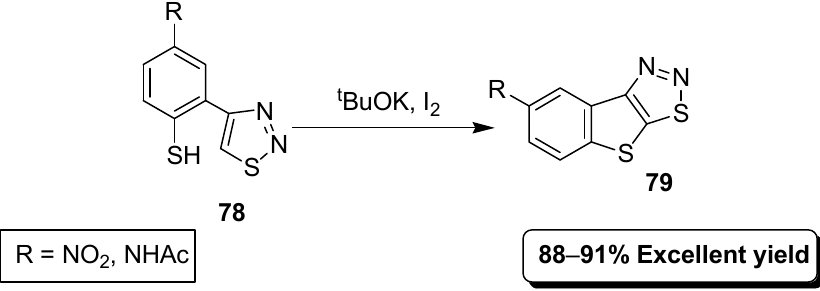
Scheme 15. Photocatalysis reaction of azoalkenes ( 76 ) with KSCN to afford 1,2,3-thiadiazoles ( 77 ). 2.10. Intramolecular Oxidative Nucleophilic Substitution of Hydrogen (ONSH)